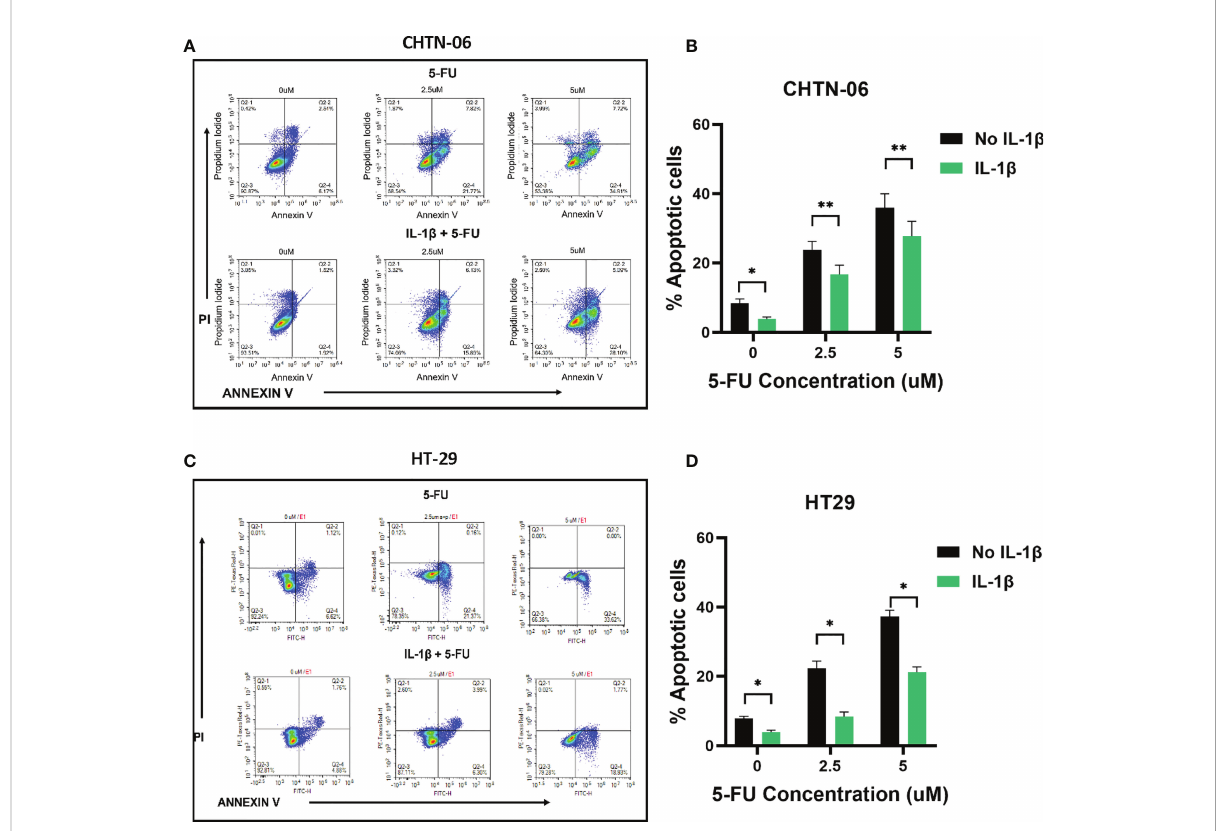
FIGURE 4 IL-1 b decreases 5-FU-induced apoptosis in MSS cell lines. Apoptosis detection by Annexin V/PI staining via fl ow cytometry following treatment with different concentrations of 5-FU (0, 2.5, 5 mM), in the presence or absence of IL-1 b . Representative images of fl ow cytometry data for CHTN-06 (A) and HT-29 (C) ; Percentage of combined early apoptotic (Annexin V+) and late apoptotic (Annexin V+/PI+) cells for CHTN-06 (B) and HT-29 (D) cell lines. Data are representative of three independent experiments. Error bars represent SEM. *p<0.05,